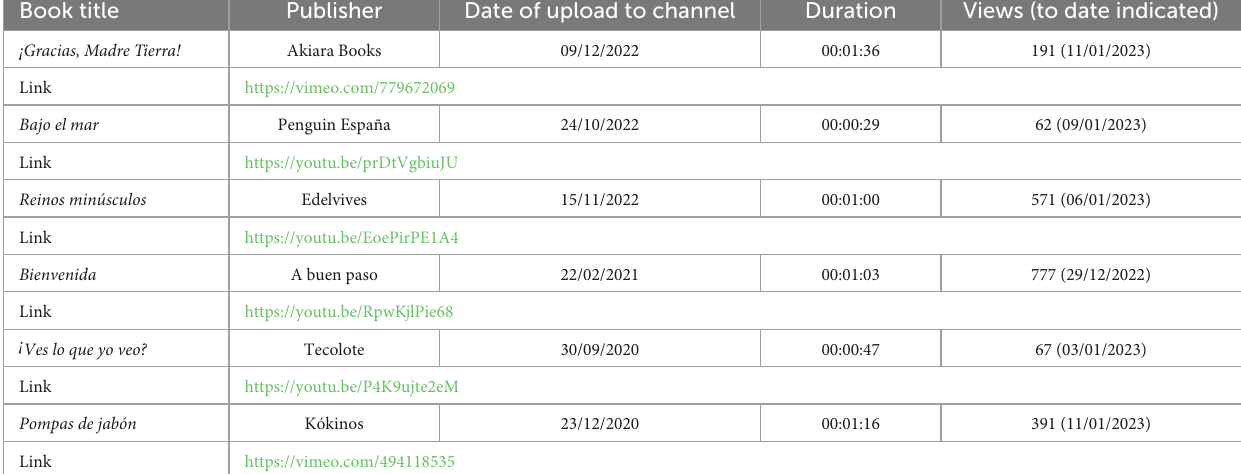
TABLE 6 Examples of virtual epitexts based on the book’s materiality.